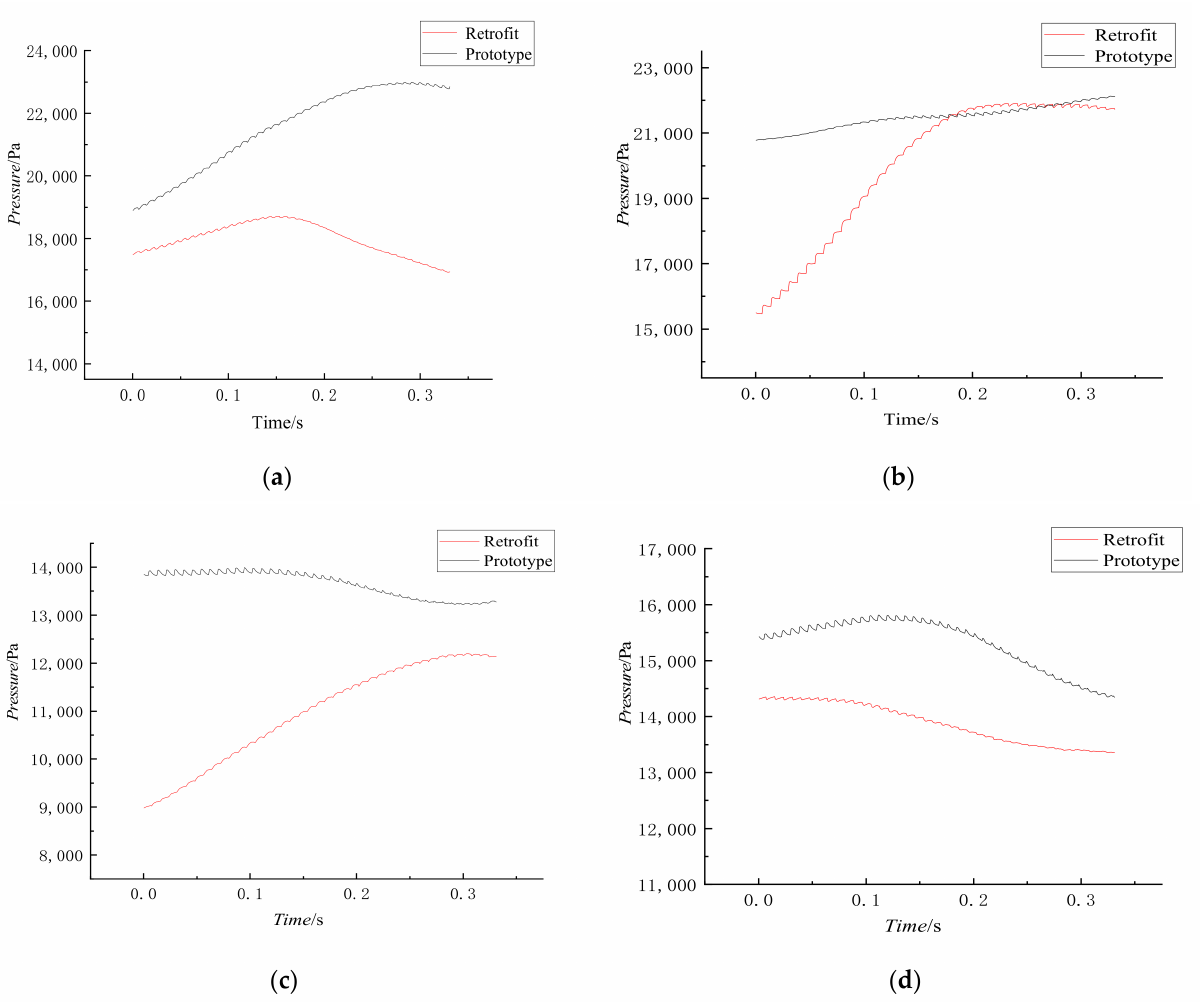
Figure 14. Time-domain diagram of monitoring point pressure pulsation. ( a ) d 1 Time domain curves. ( b ) d 3 Time domain curves. ( c ) d 5 Time domain curves. ( d ) d 7 Time domain